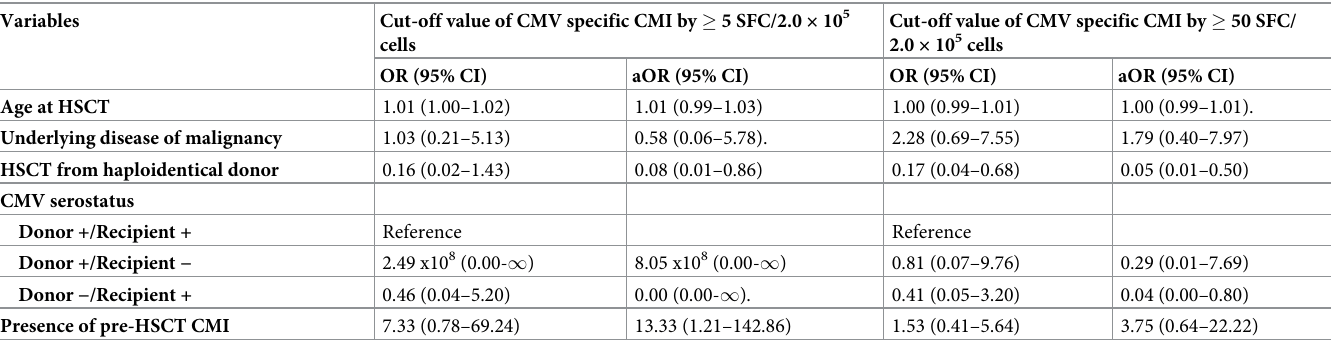
Table 4. Factors associated with the recovery of CMV specific CMI following HSCT.